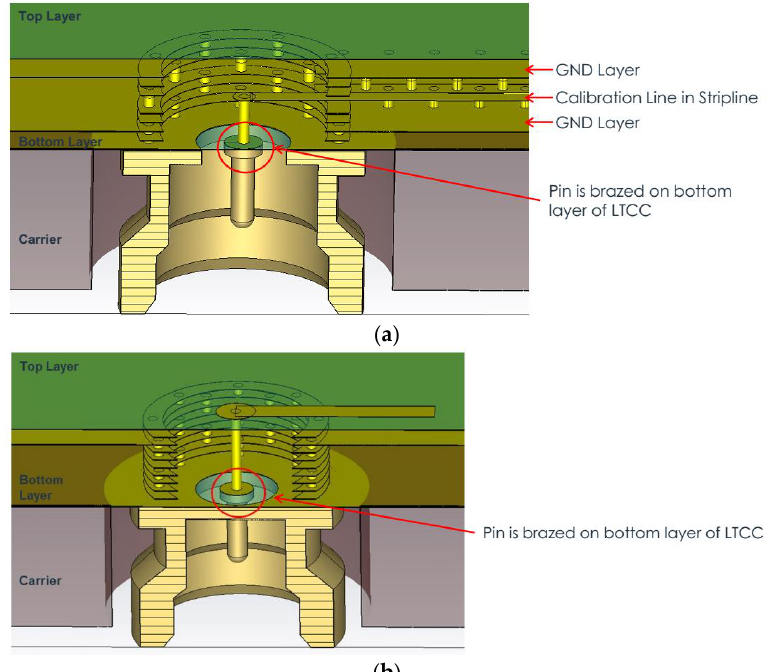
Figure 10. Three-dimensional overview of the transitions: ( a ) stripline to coaxial connector, ( b ) microstrip to coaxial connector.